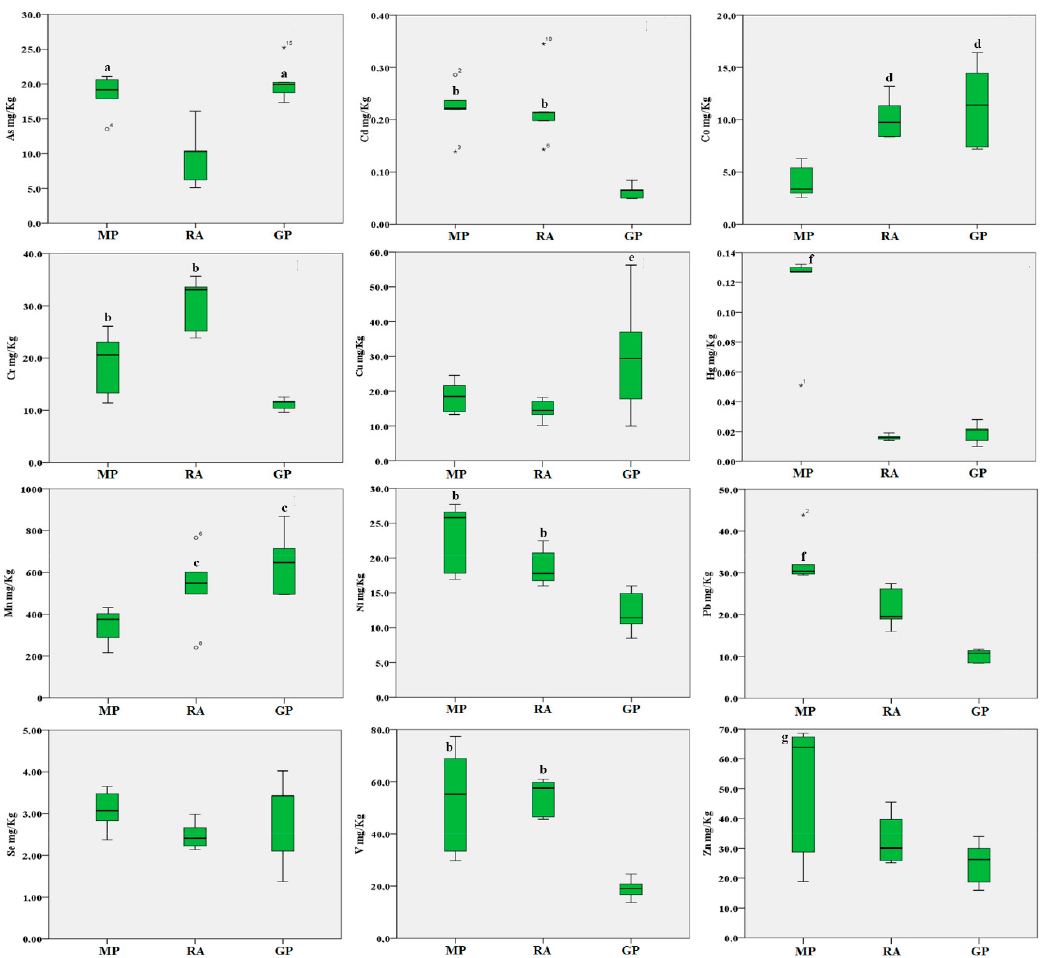
Figure 4. Boxplot of the trace elements in soil samples (mg/kg d.w.) from the three areas. MP: Magnisi peninsula; RA: Ragusa agro-ecosystem; GP: Gela plain. The box represents the interquartile (IQ) range contains the 1st quartile, the median and the 3rd quartile; whiskers represent extreme values of minimum and maximum; in addition, outliers with values between 1.5 and 3 times the IQ range are displayed. Legend: a = p<0.05 vs MP and GP; b = p<0.01 vs GP; c = p<0.05 vs MP; d = p<0.01 vs MP; e = p<0.05 vs MP and RA; f = p<0.01 vs RA and GP; g = p<0.05 vs RA and GP.